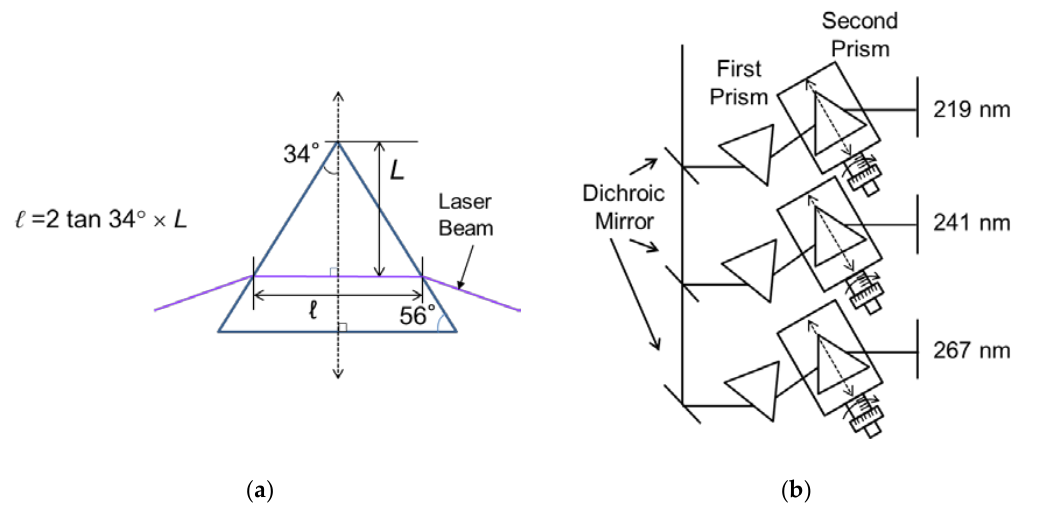
Figure 1. ( a ) Prism parameters; ( b ) configuration of the prisms in a pulse compressor. Dotted arrows show the direction of displacement of the prisms. The parameters, ℓ and L , are the path length of the laser beam in the prism and the distance from the top of the prism to the laser beam, respectively. The angle of the prism is specified in the figure. Three prisms in ( b ) can be manually translated by rotating the nobs of the differential micrometers independently.